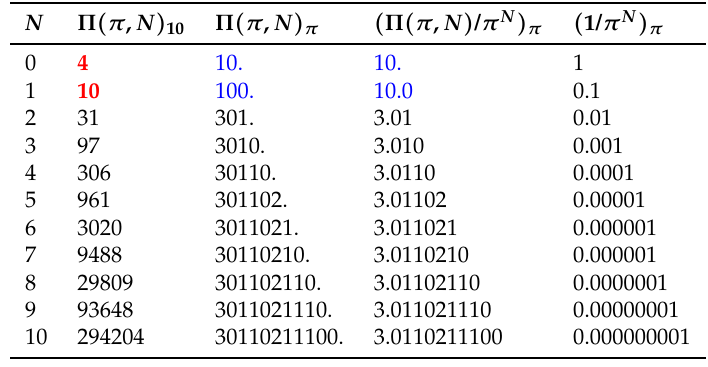
Table 8. Number of collisions Π ( π , N ) given by (13) for b = π . The first column is N . The second column is the number of collisions in the decimal base. The third column is the integer part of the number of collisions Π ( π , N ) written in the base π . The fourth column is the number π with N digits in the fractional part in the base π . The fifth column gives the systematic error according to Equation (55). The case N = 1 is emphasized since there is the difference 1 between Π ( π ,1 ) by (13) and the approximation (14). The cases where approximation (14) fails as compared to (13) are highlighted by red. The blue bold digits are not correctly predicted by the Galperin billiard. N Π ( π , N ) 10 Π ( π , N ) π